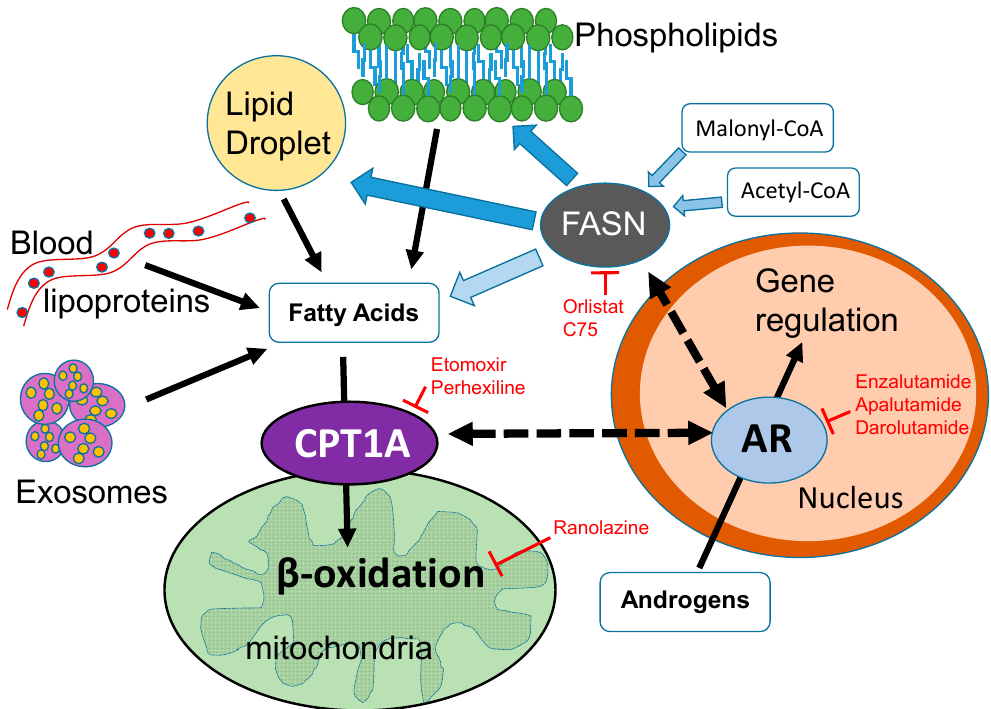
Figure 1. Cross-talk between lipid metabolism and the androgen receptor (AR) in the nucleus. The dotted arrows represent unknown mechanisms connecting fat burning in the mitochondria via CPT1A (carnitine palmitoyltransferase 1A) and fat synthesis in the cytoplasm via the FASN (fatty acid synthase) enzyme. Solid black arrows show direct connections. Red labels and red T-bars represent inhibitory drugs that are used in the clinic. Etomoxir and C75 are not used in humans. This diagram shows some of the sources of fatty acids available to the mitochondria, including the lipids that are newly synthesized via FASN. Light blue arrows show the substrates for FASN and its product, the fatty acid palmitate. This fatty acid of 16 carbons can be elongated and/or desaturated. The proportion of newly synthesized fatty acid that is burned in PCa is unknown, Dark blue arrows show that it can also be used for phospholipid and lipid droplet formation, which contains triglycerides and cholesterol esters. Exosomes delivering lipid droplets and phospholipids also represent another source of fatty acids for beta oxidation. Since androgens are known to regulate CPT1A and FASN enzyme activities, the coordination of fat synthesis and oxidation is likely modulated by the environmental context of the tumor, sometimes tipping the balance more towards synthesis and other times towards oxidation. Elucidating these tumor dependencies will increase the efficacy of lipid metabolic inhibitors and their combination with anti-androgen blockades.